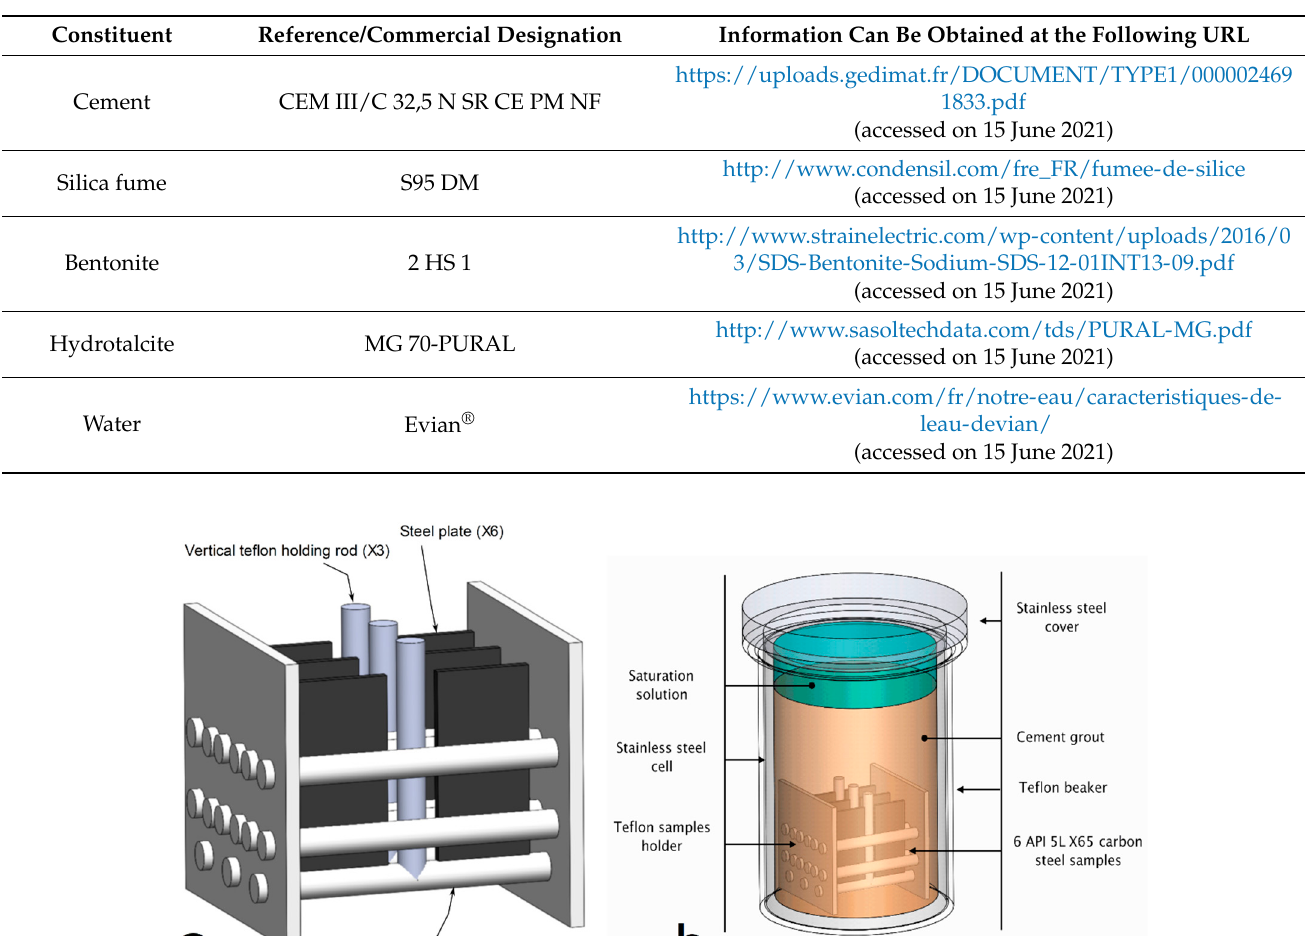
Table 2. Preparation of the cement grout: constituents used and corresponding information.